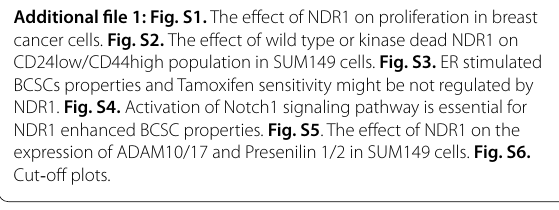
NDR1. Fig. S4. Activation of Notch1 signaling pathway is essential for NDR1 enhanced BCSC properties. Fig. S5 . The effect of NDR1 on the expression of ADAM10/17 and Presenilin 1/2 in SUM149 cells. Fig. S6.